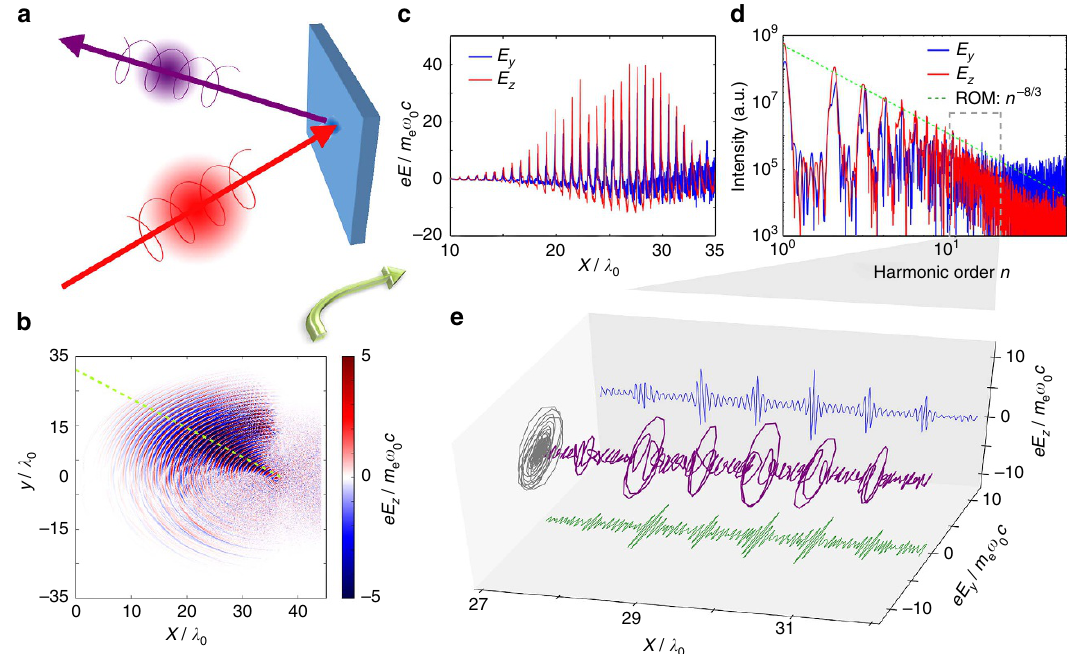
Figure 1 | Scheme and 2D simulation results. ( a ) The proposed experimental configuration for generation of the polarization-controlled harmonics by a CP laser pulse obliquely incident on a plasma surface. The red and purple arrows represent the incident laser pulse and the reflected XUV harmonics, respectively. ( b ) A snapshot of the electric field component E z of the reflected pulse from the 2D simulation results at time t ¼ 36 T 0 . The green dashed line marks the specular reflection direction. ( c ) Temporal waveform and ( d ) the corresponding Fourier spectra of the reflected pulse along the specular reflection. The green dashed line in panel ( d ) corresponds to the predicted scaling law I ROM ( n ) p n (cid:2) 8/3 by the ROM theory. ( e ) The reconstructed 3D image of the electric field vector of the attosecond pulses (purple), obtained after spectral filtering by selecting the 10th–20th harmonic orders (indicated by the harmonics within the dashed grey box in panel d ). Waveform of the two orthogonal electric field components E y (green) and E z (blue), as well as the projection of E y (cid:2) E z (grey), are also